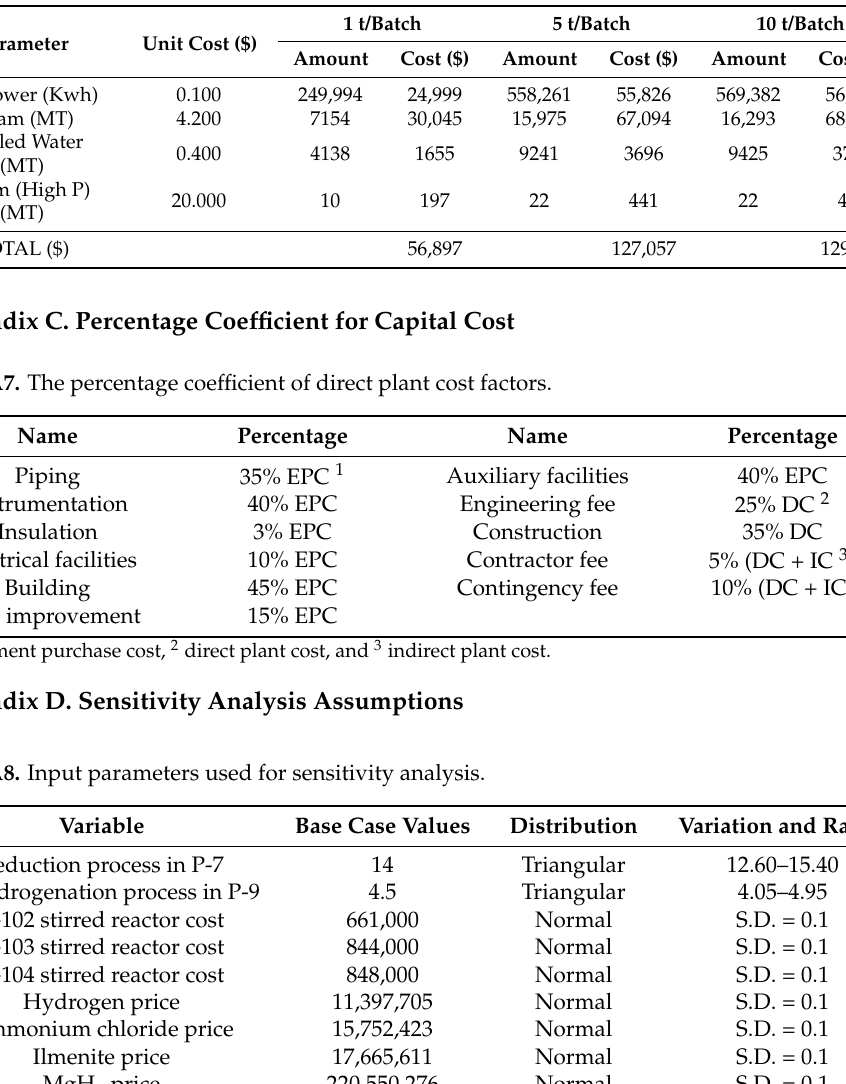
Table A6. Annual utilities cost for different production scale of Ti powder.